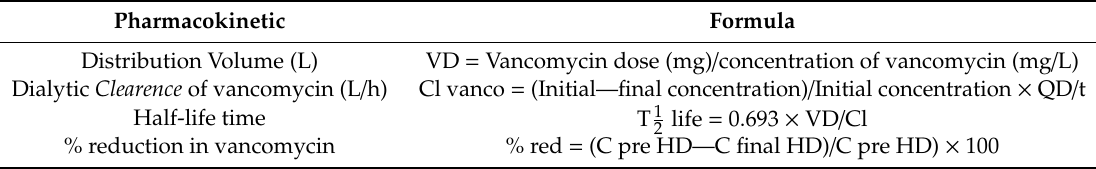
Table 1. Formulas utilized for the calculation of Vancomycin pharmacokinetic [18–20].